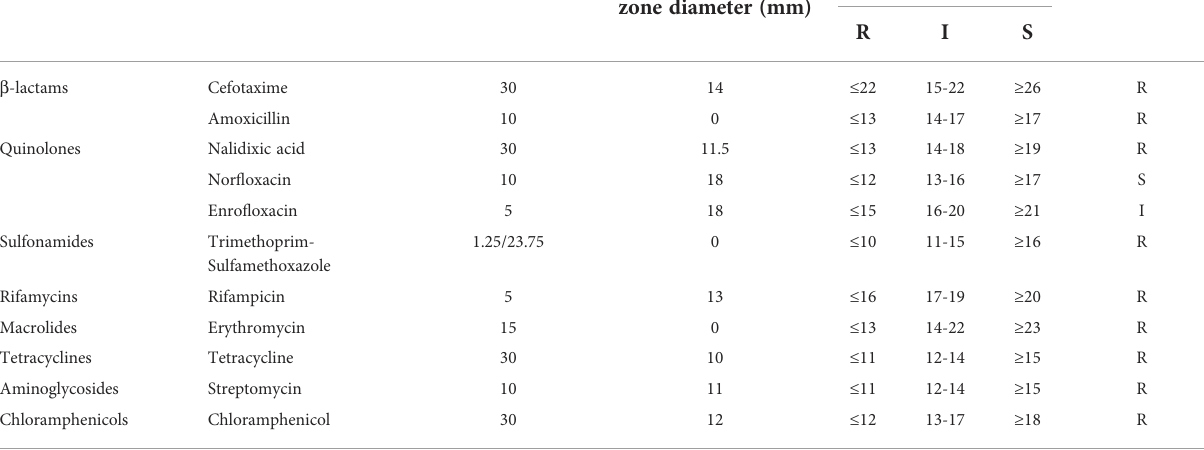
TABLE 1 Antimicrobial susceptibility pro fi le of A. hydrophila MX16A. Antimicrobial